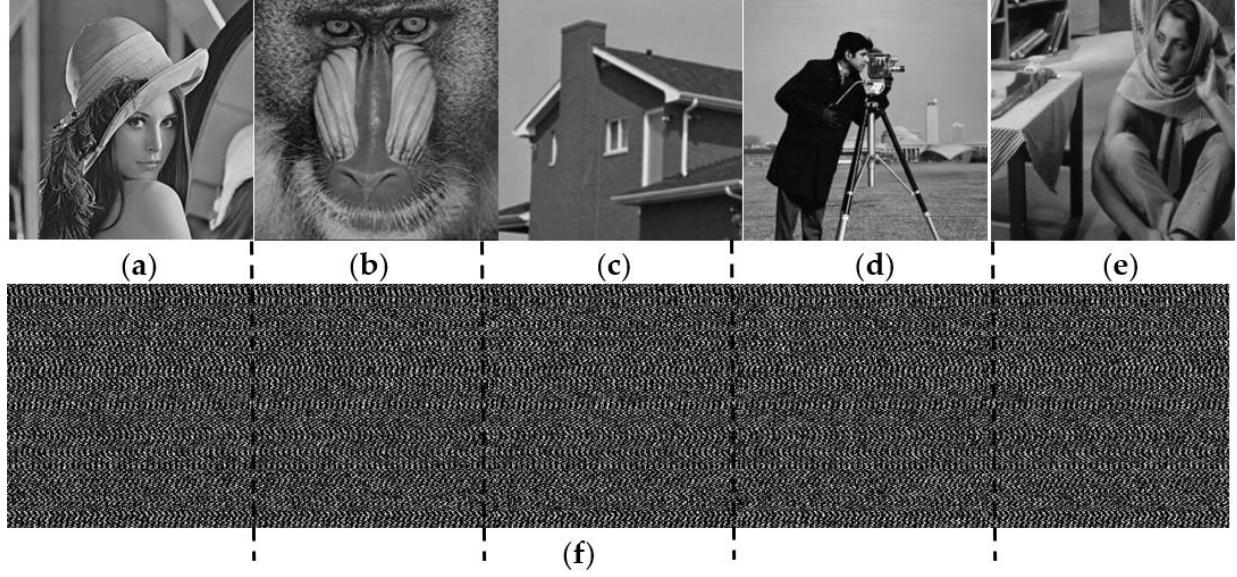
Figure 5. Example of generated shared image by (3, 4, 5) thresholds: ( a – e ) secret images, ( f ) the generated shared image S 1 .